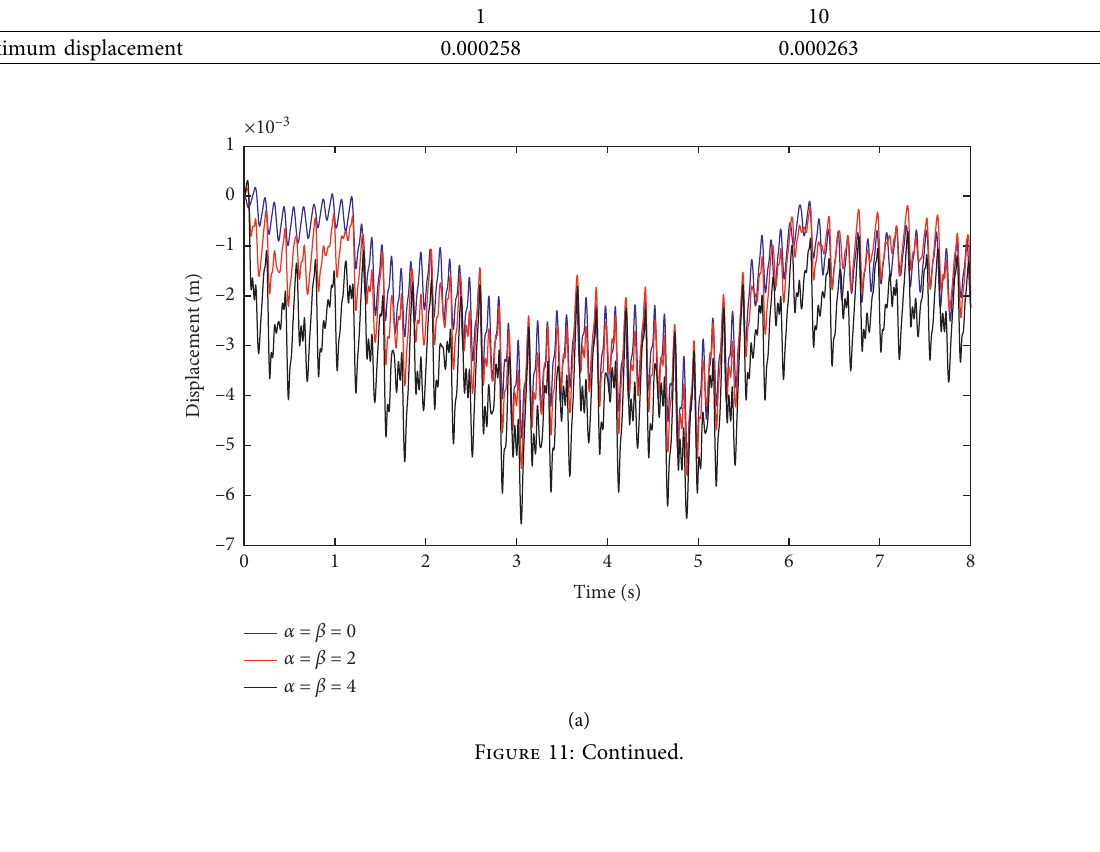
Figure 10: Controlled system behavior for different magnitudes of η and λ � 1. (a) (b). Detailed view of2 (a). Table 5: Maximum displacement versus η .